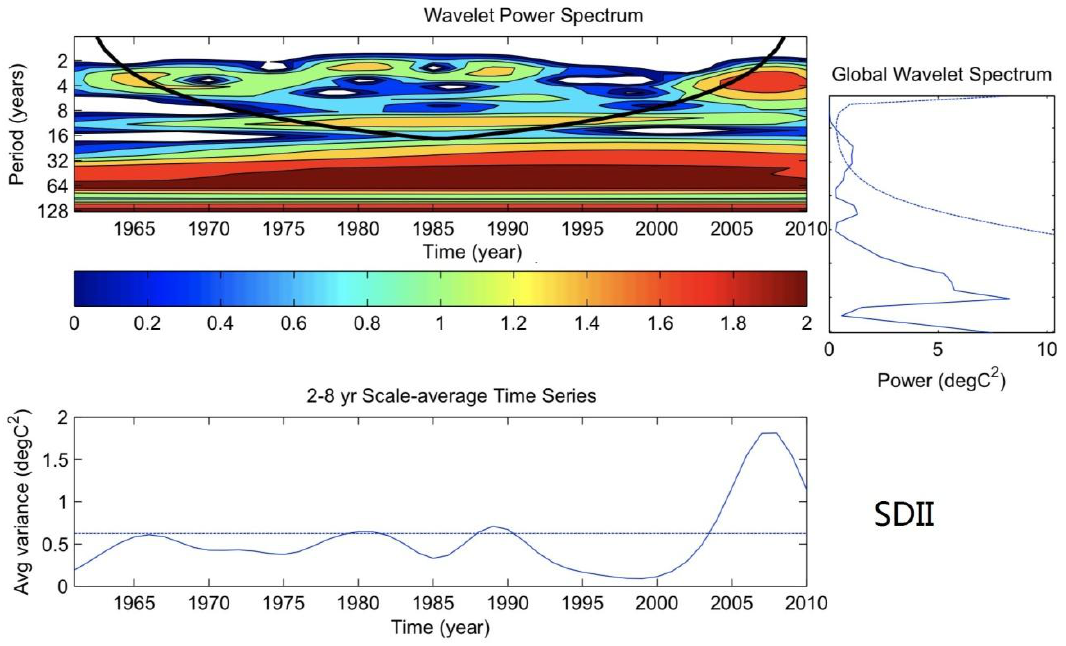
Figure A5. Local and global wavelet spectra for regional average annual SDII time series.